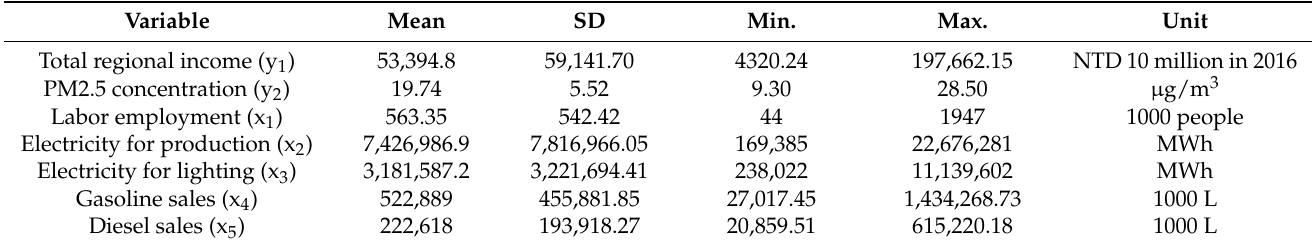
Table 1. Summary of statistics for regional output and input data in Taiwan in 2016.